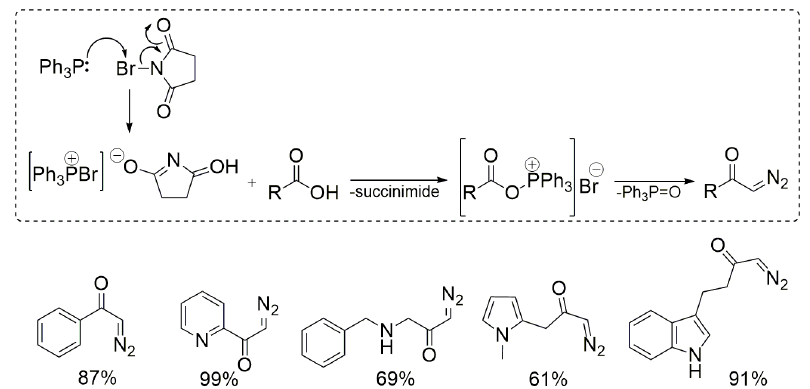
Figure 10 - Synthesis of diazoketones from acyloxyphosphonium salts and diazomethane.